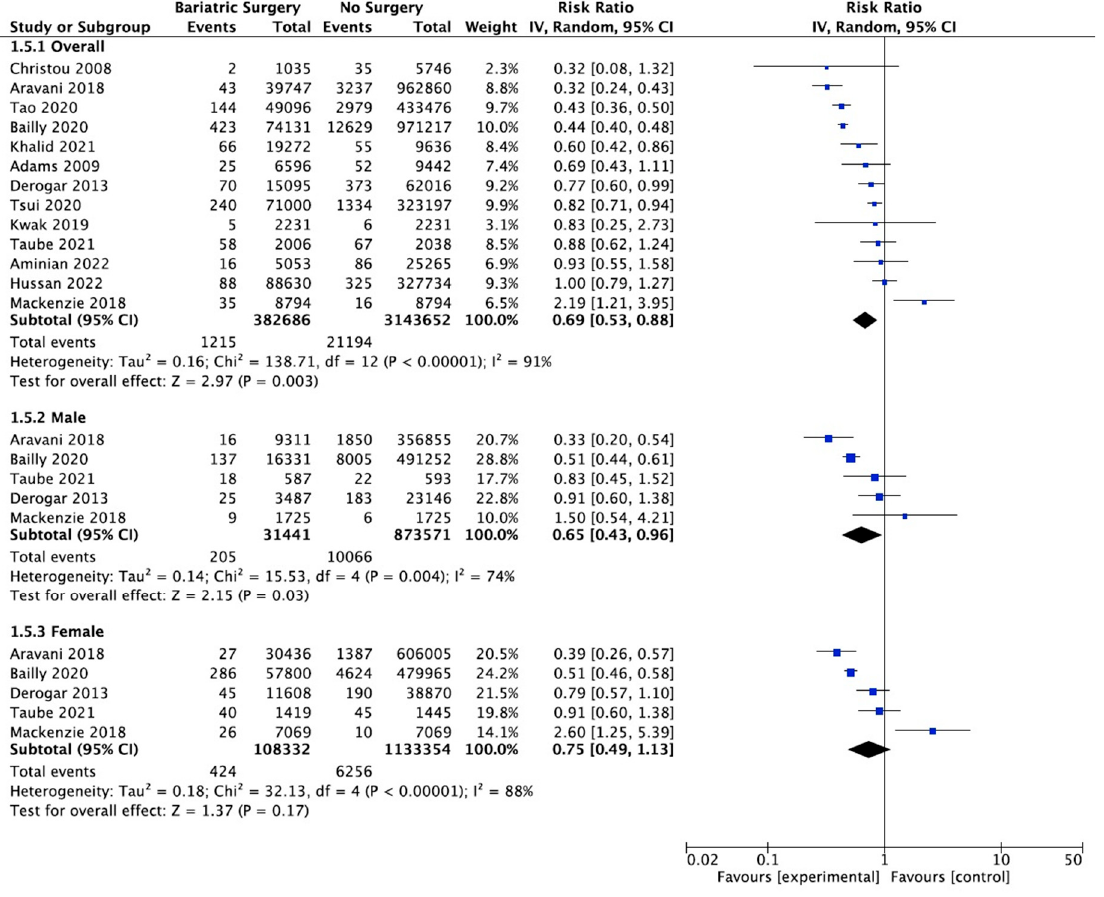
Figure 9. Colorectal cancer incidence [38,40,42,43,45,49,50,58–63].